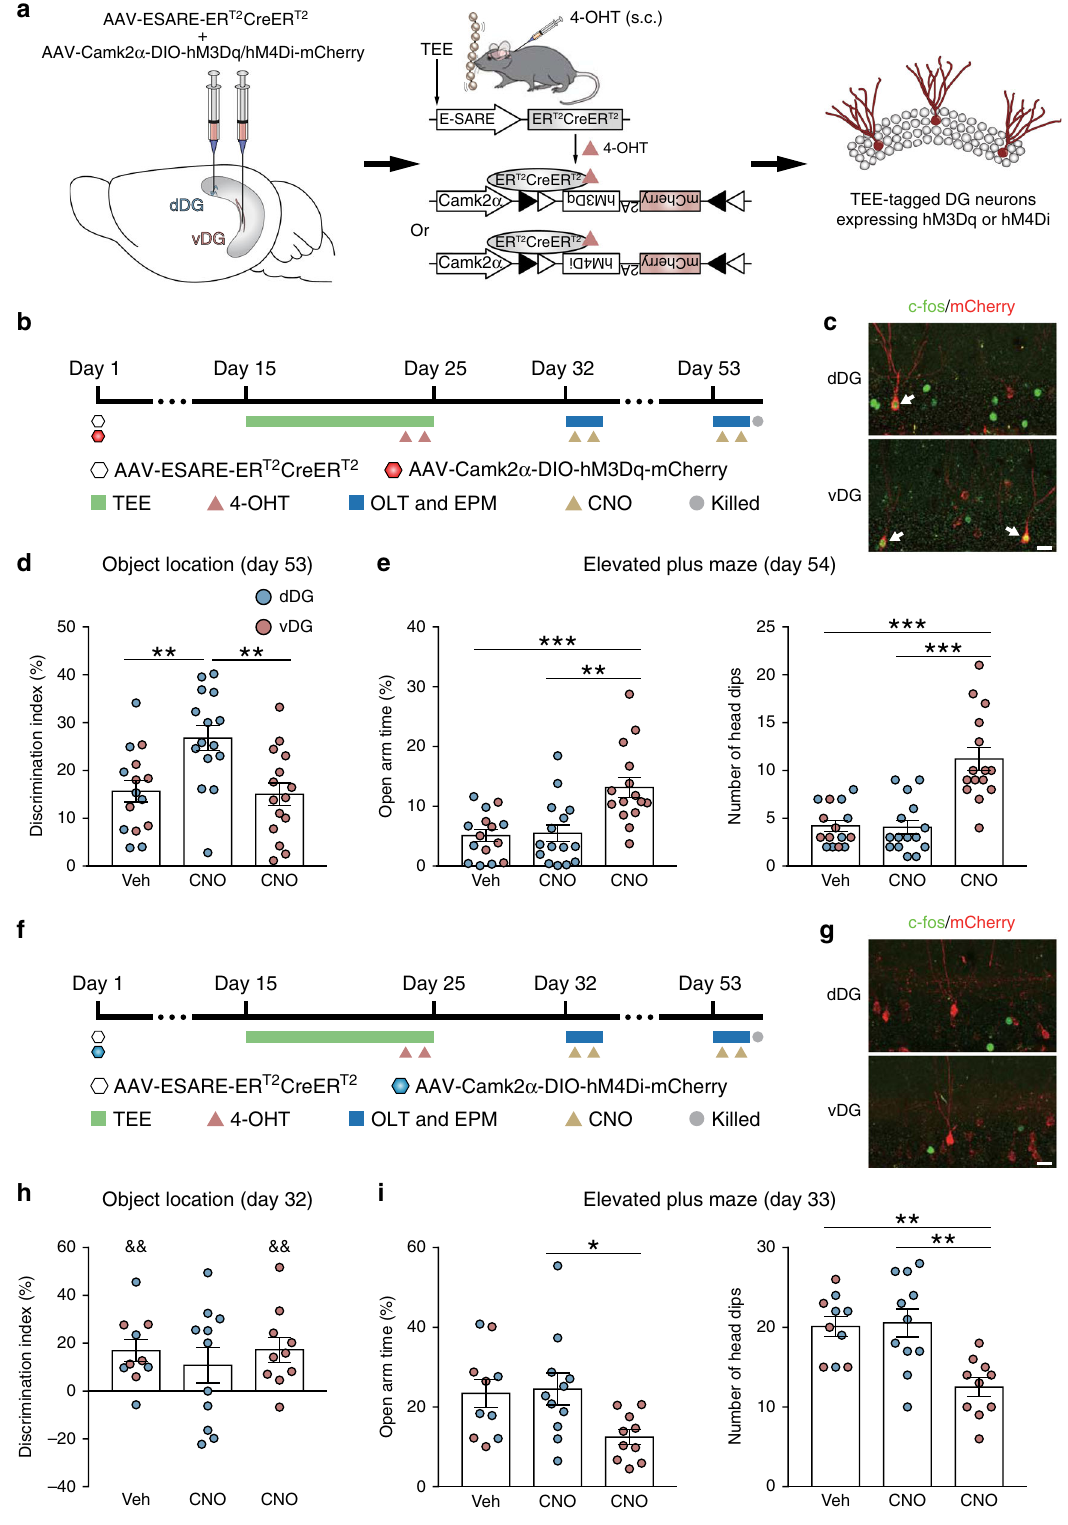
by tactile enrichment. These results suggest that the behavioral effects of tactile enrichment are not dependent on adult hippo- campal neurogenesis. Since most tactile enrichment-activated DG neurons were calbindin + granule cells, tactile enrichment mainly targets and remodels mature DG neurons to modulate memory and anxiety